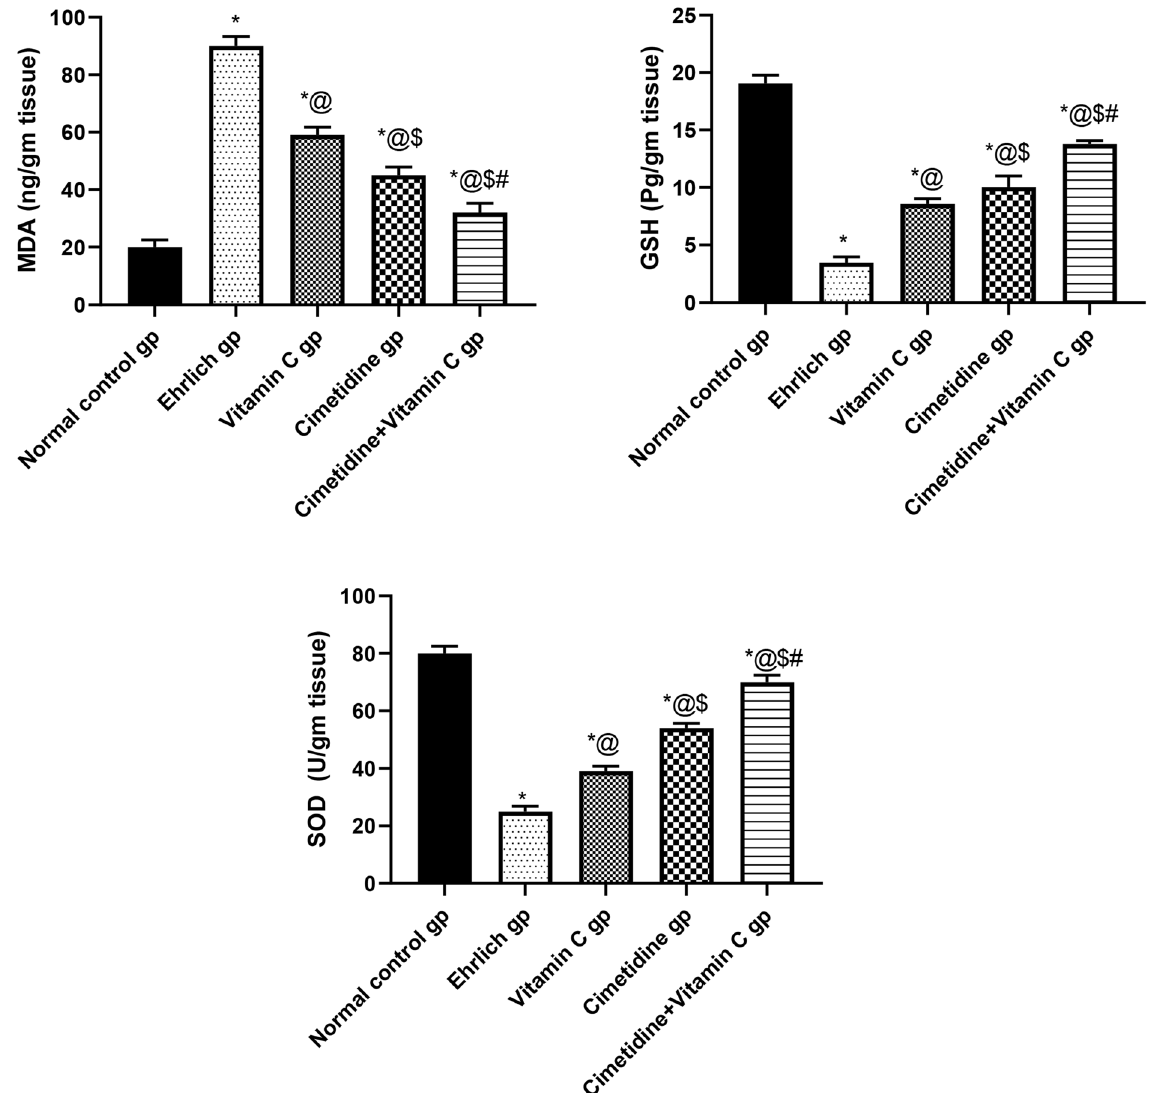
Figure 6. The changes in the tissue levels of oxidative stress parameters (MDA, GSH, SOD) following treatment with cimetidine at a dose of 200 mg/kg/day, vitamin C at a dose of 4 g/kg/day, and their combination for 15 days after Ehrlich induction of breast cancer in mice. Data are presented as mean ± SD.* is significantly different from the normal control group, P < 0.05. @ is significantly different from Ehrlich untreated group, P < 0.05. $ is significantly different from the vitamin C-treated group, P < 0.05. # is significantly different from cimetidine- treated group, P <